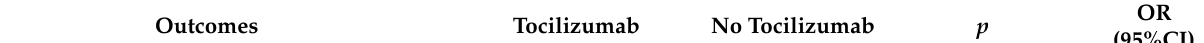
Table 4. Tocilizumab effect on rates of death, need for mechanical ventilation, and clinical improvement depending on combinations of possible outcomes